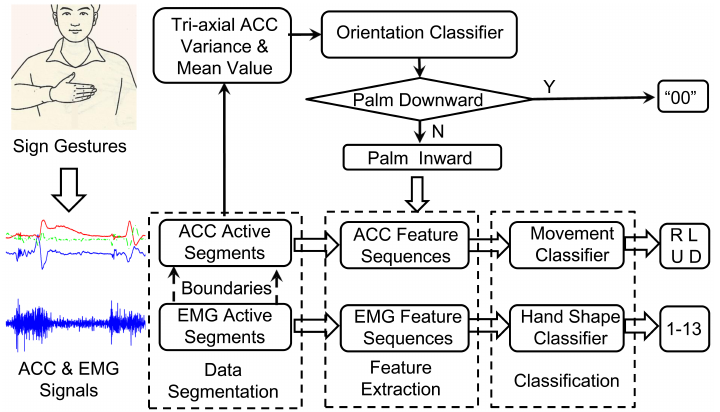
Figure 6. Illustration of the block diagram of the proposed